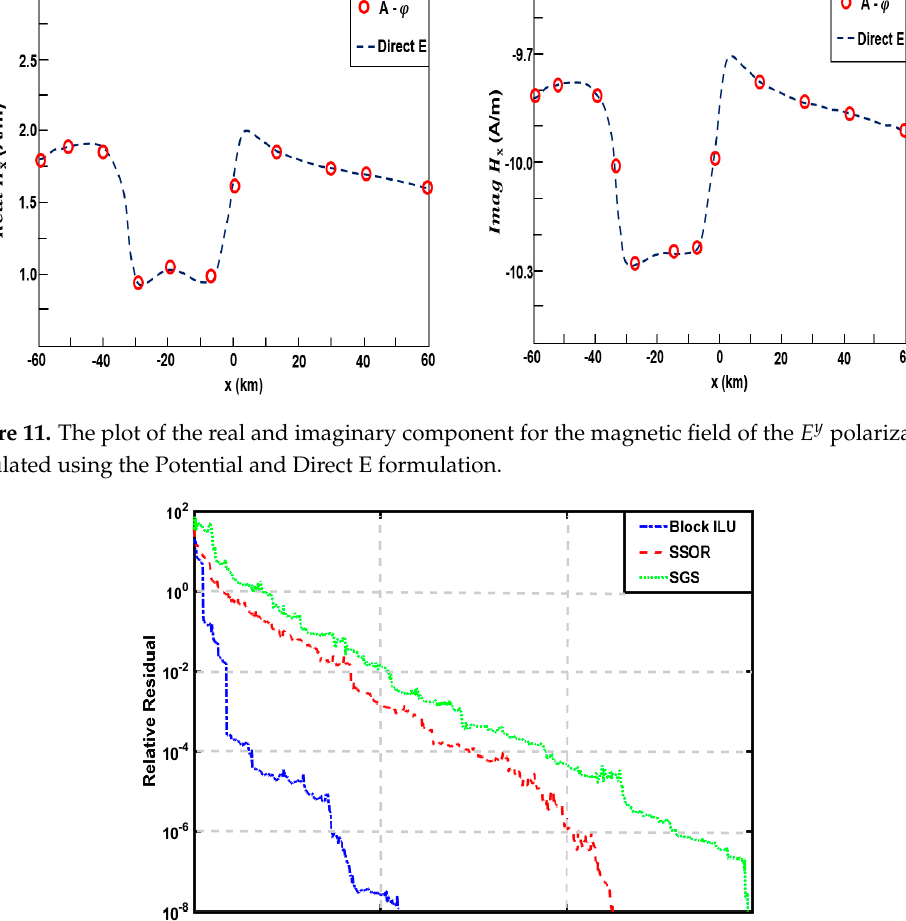
Figure 10. The plot of the real and imaginary component for the normalized electric field of the 𝐸 (cid:3051) polarization calculated using the Potentials and Direct E formulation.